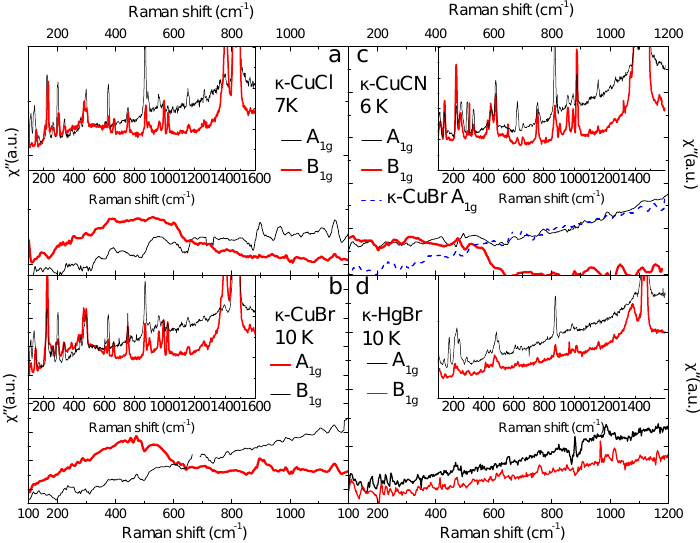
Figure 2. Low temperature Raman spectra for the discussed κ phase materials in the spectral range between 100 and 1600 cm − 1 in polarizations corresponding to A 1 g and B 1 g in D 4 h symmetry. The insets show original data, the main figures show data with phonons and luminescence contribution subtracted. The resulting spectra, containing magnetic and, possibly, electronic contributions are plotted ( a ) Spectra of κ -(BEDT-TTF) 2 Cu[N(CN) 2 ]Cl at 7 K. Note the broad maximum in B 1 g symmetry between 100 and 700 cm − 1 ; ( b ) Spectra of κ -(BEDT-TTF) 2 Cu[N(CN) 2 ]Br at 10 K. Note the broad maximum in B 1 g symmetry between 100 and 700 cm − 1 , similar to κ -(BEDT-TTF) 2 Cu[N(CN) 2 ]Cl; ( c ) Spectra of κ -(BEDT-TTF) 2 Cu 2 (CN) 3 at 6 K. The continuum extends from about 600 cm − 1 to the lowest measured frequencies, no gap in magnetic spectrum can be identified, in contrast to κ -(BEDT-TTF) 2 Cu[N(CN) 2 ]Cl and κ -(BEDT-TTF) 2 Cu[N(CN) 2 ]Br. The dashed line shows A 1 g contribution of κ -(BEDT-TTF) 2 Cu[N(CN) 2 ]Br for comparison, which makes clear the presence of an additional intensity below 600 cm − 1 in A 1 g for κ -(BEDT-TTF) 2 Cu 2 (CN) 3 , which we attribute to magnetic excitations; ( d ) Spectra of κ -(BEDT-TTF) 2 Hg(SCN) 2 Br at 10 K, the spectra do not show major differences between A 1 g and B 1 g channels in the discussed range, no continuum of magnetic excitations is